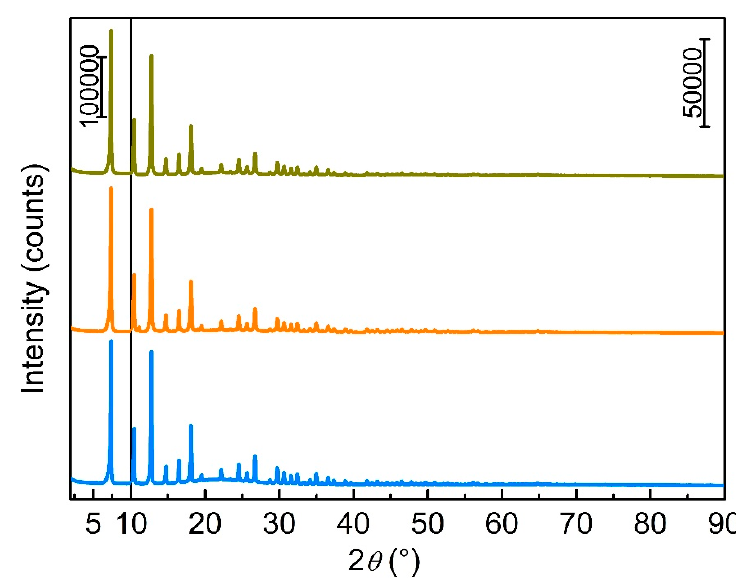
Figure 3. Powder X-ray diffraction (XRD) of ZIF-8 materials exposed to air after reactivation at 200 °C following the EtO/CO 2 ( orange curve ) and PrO/CO 2 reaction ( dark yellow curve ). The pattern of the fresh material is reported for comparison ( blue curve ).